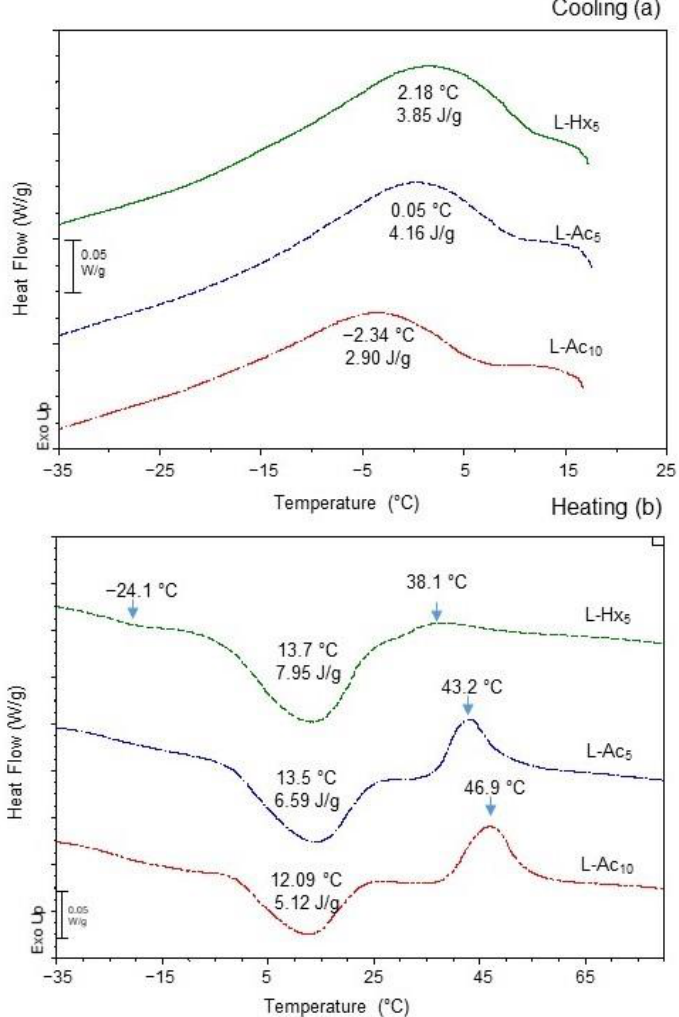
Figure 2. Differential scanning calorimetry (DSC) traces of lyophilized liposomal dispersions upon